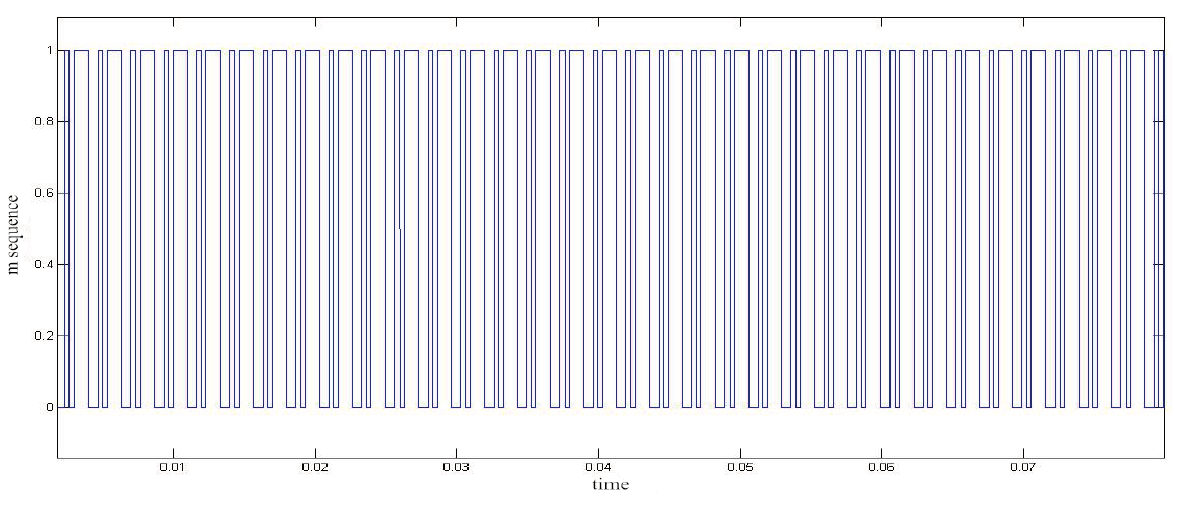
Figure 13. The simulation result of the M-sequence